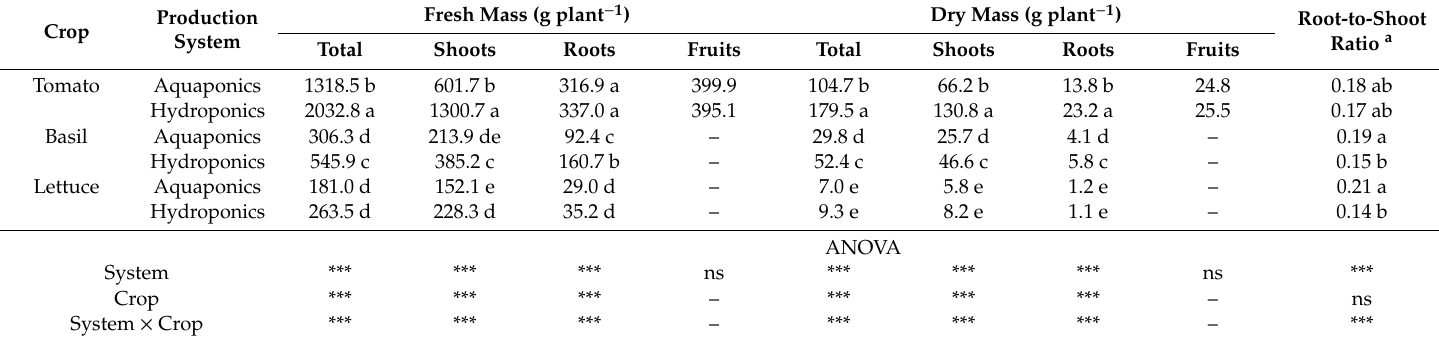
Fresh Mass (g plant − 1 ) Dry Mass (g plant − 1 ) Root-to-Shoot